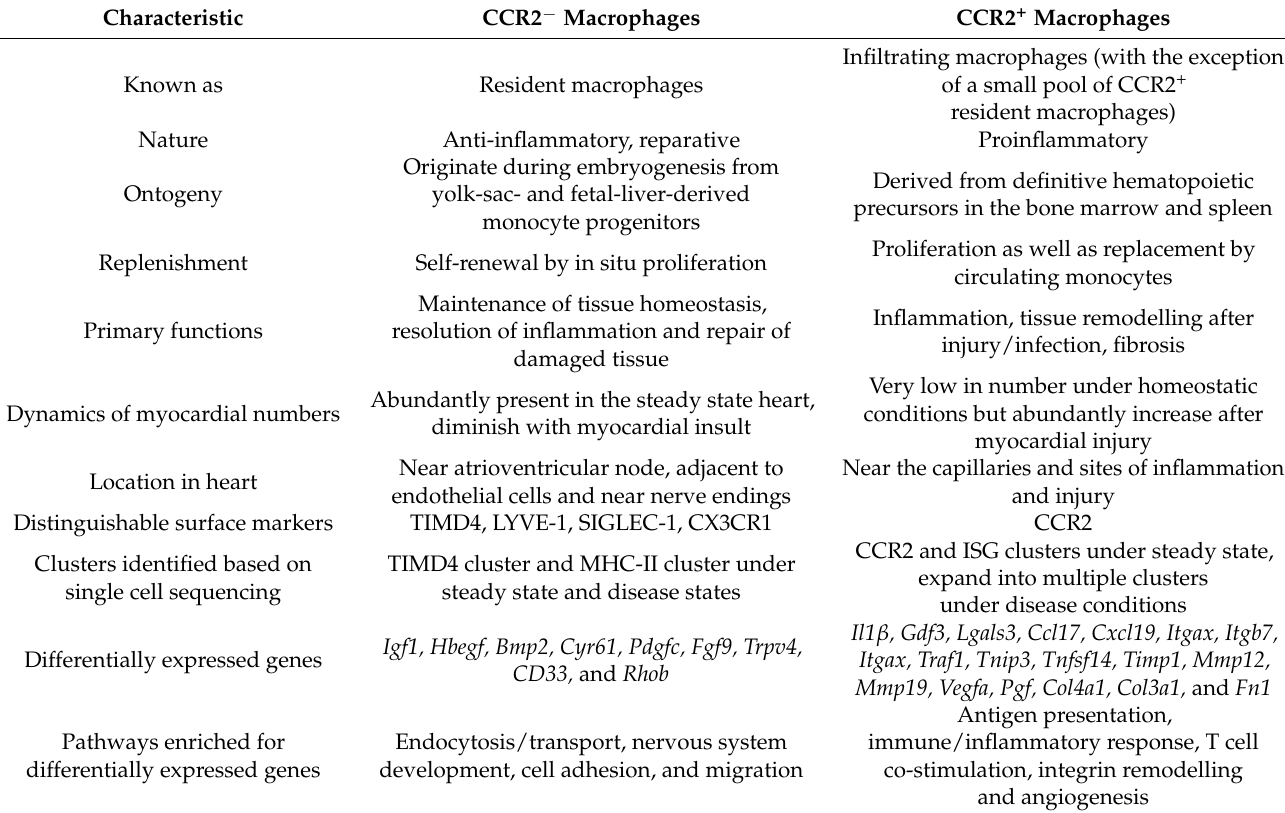
Table 2. Reported differences between CCR2 − and CCR2 + cardiac